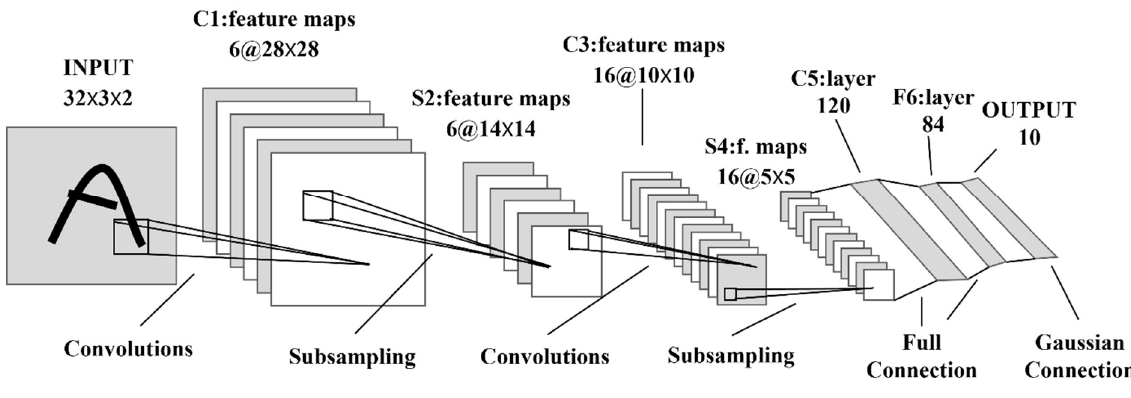
Figure 2. Convolutional Neural Network.